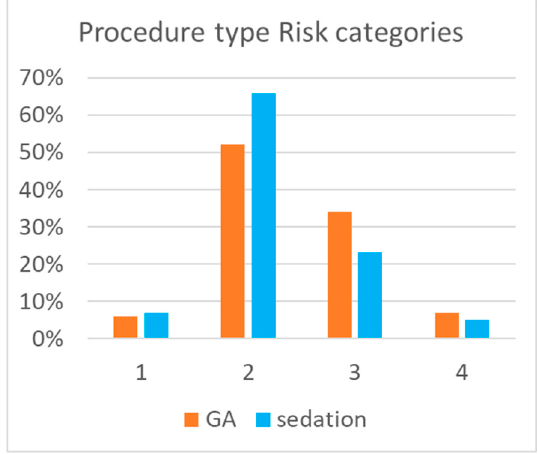
Figure 2. Distribution of procedure -type risk in each general anesthesia or sedation groups. Table 2. Pre-procedural characteristics of patients.